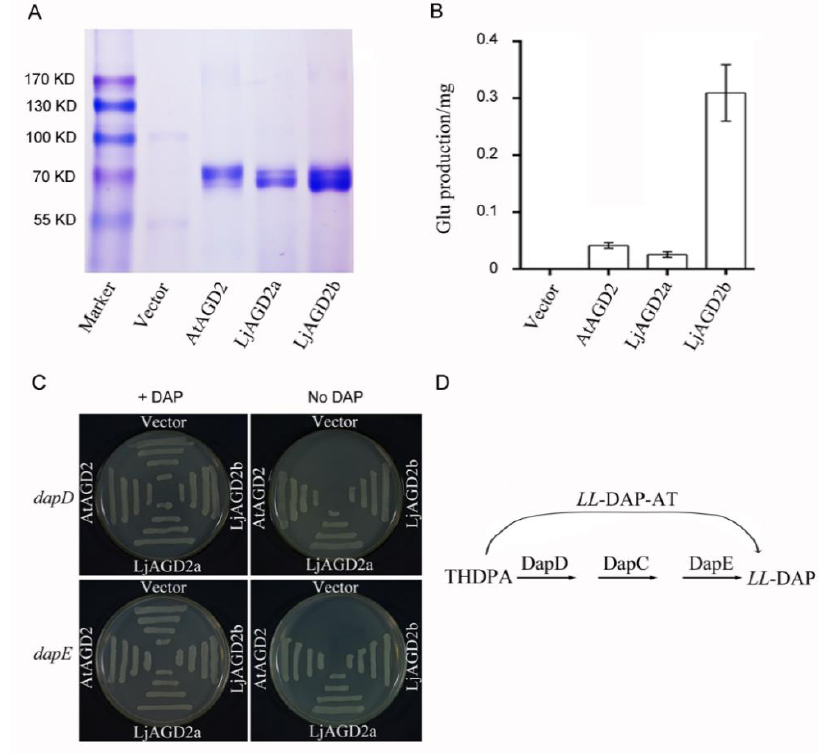
Figure 3. Aminotransferase activities of AGD2s in E. coli . ( A ) Electrophoretic patterns of recombinant proteins purified using a Ni 2+ -nitrilotriacetic acid column. ( B ) Aminotransferase activities of AGD2s, assayed using 50 mM Lys and 50 mM 2-oxoglutarate as substrate and co-substrate, respec- tively. Aminotransferase activity was determined by measuring the concentration of the reaction product Glu. Bars indicate standard deviations ( n = 3). ( C ) Complementation of dap mutants with AGD2. Strains AT980 ( dapD mutant) and AT984 ( dapE mutant) were transformed with either the plasmid vector (pGEX-KG) or an LjAGD2a, LjAGD2b and AtAGD2 (At4g33680) expression plasmid (pGEX-KG-AGD2). Colonies were selected on LB medium with 50 µg/mL DAP and 100 µg/mL am- picillin. Individual colonies were then plated onto NZY medium supplemented with 0.2% ( w / v ) Ara with or without 50 µg/mL DAP. The cultures were grown at 37 °C for 12 h. ( D ) Diagram of the DAP pathway in E. coli with the reaction catalyzed by LL -DAP-AT indicated. 2.3. LjAGD2a Affects Plant Morphology and Development To assess the effects of changing expression of LjAGD2 on L. japonicus , we obtained an insertional mutant line ljagd2a (LORE ID: 30001979, Figure S4A) and three LjAGD2a overexpression lines (designated OeLjAGD2a-1 , OeLjAGD2a-3 and OeLjAGD2a-6 ). The ex- pression of LjAGD2a in each line was detected by semi-quantitative or quantitative PCR (Figure S4B,C). We assayed LL -DAP-AT activity in leaves of the mutant and transgenic plants. The results showed that overexpression of LjAGD2a significantly increased, and the mutation of LjAGD2a significantly decreased LL -DAP-AT activity in L. japonicus . Over- expression of LjAGD2a in ljagd2a increased the transcription level of LjAGD2a and par- tially restored LL -DAP-AT activity (Figure 4A). Compared to wildtype controls, ljagd2a mutants showed retarded growth, delayed flowering and smaller seeds, while overexpression of LjAGD2a in L. japonicus resulted in dwarf shoots, early flowering and larger seeds (Figure 4B,C,F – H). Additionally, OeL- jAGD2a lines had shorter pods, larger floral organs and thicker leaves ( Figure 4C – F ). Ow- ing to the roles of AtAGD2 in embryo development in Arabidopsis, we also assessed the effects of LjAGD2a on the seed setting rate and pollen fertility. No significant differences in seed setting rate and pollen fertility between the wildtype (Gifu B-129) and the ljagd2a mutant were observed (Figure 5). However, OeLjAGD2a-3 and OeLjAGD2a-6 plants had 60 – 75% lower seed setting rates than wildtype plants (Figure 5A,B). In addition, iodine-